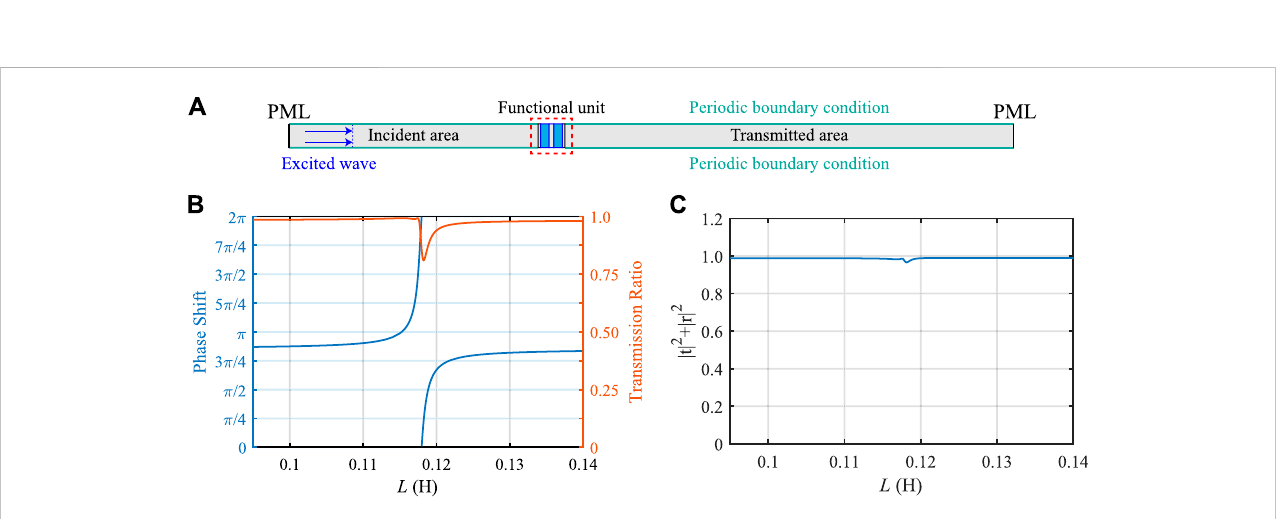
FIGURE 3 (A) Plate with one functional unit. (B) Phase shift and transmission ratio and (C) the sum of square of the transmission ratio and square of the re fl ection ratio of the A 0 -mode Lamb wave at frequency 14 kHz with varying L .